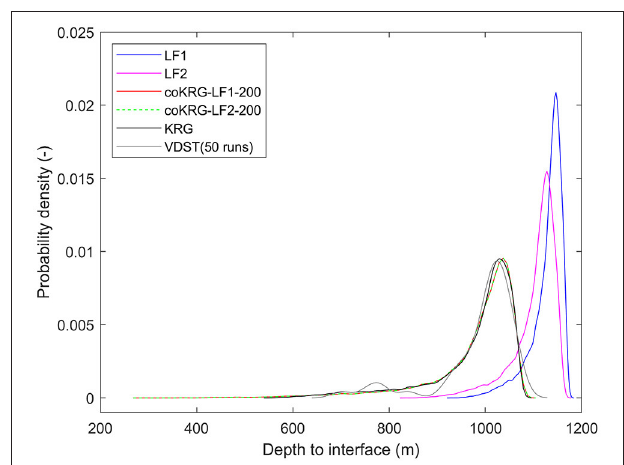
FIGURE 8 | Estimated PDFs of the QoI (average depth to freshwater-brine interface) based on the surrogate models, the LF models and the HF